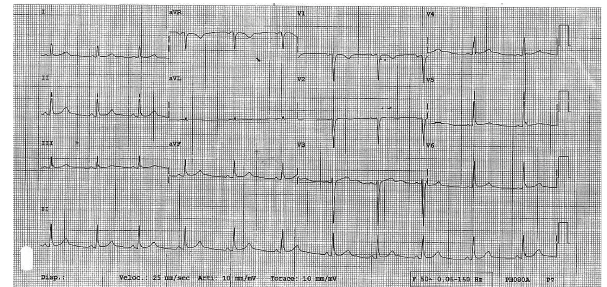
Figure 1: ECG performed 6 hours after presentation to the ED, when symptoms had regressed. The tracing shows lack of R-wave progression from V1 to V3 and is otherwise nondiagnostic.